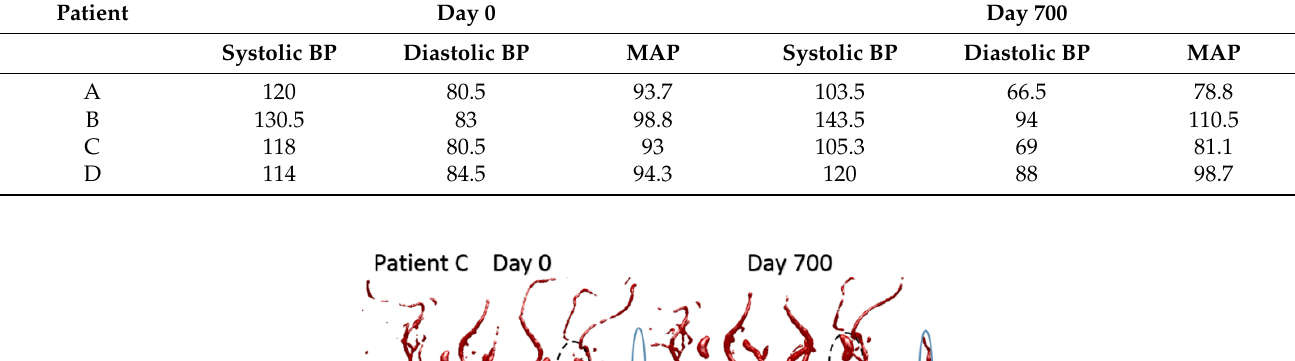
Figure 5. Sample patient CDFs demonstrating the temporal changes from day 0 to 700. The graphs indicate the probability that blood vessels may be of a certain diameter or less. ( A – D ) represents 4 different patients from our dateset. Table 3. BP measurements of patients A, B, C, and D. Table 3. BP measurements of patients A, B, C, and D.